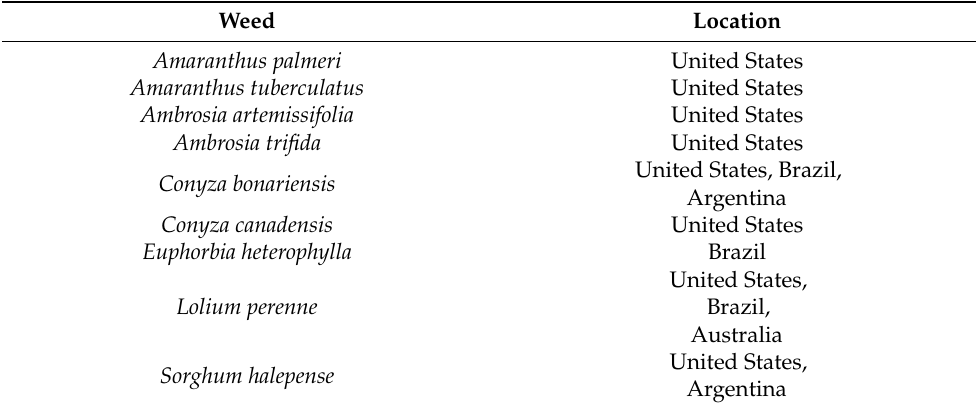
Table 1. Example of glyphosate-resistant weeds and their locations, extended from reference [29].